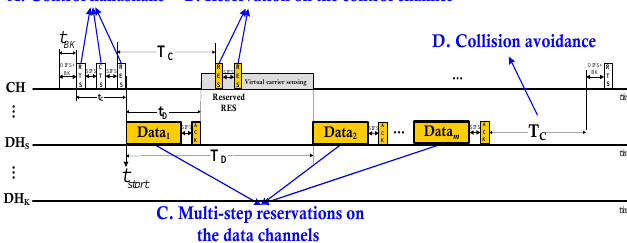
Fig. 1. The operation of m -RCR protocol. The process contains four stages: Control handshake (including RTS/CTS/RES packets exchange), Reservation on the control channel (the RES packet is reserved to re-broadcast on the control channel by both of the source node and destination node, respectively), Multi-step reservations on the data channels (multiple data transmissions are reserved with only one successful control handshake), and Collision avoidance (a new control channel handshake will not be initiated until after a period of